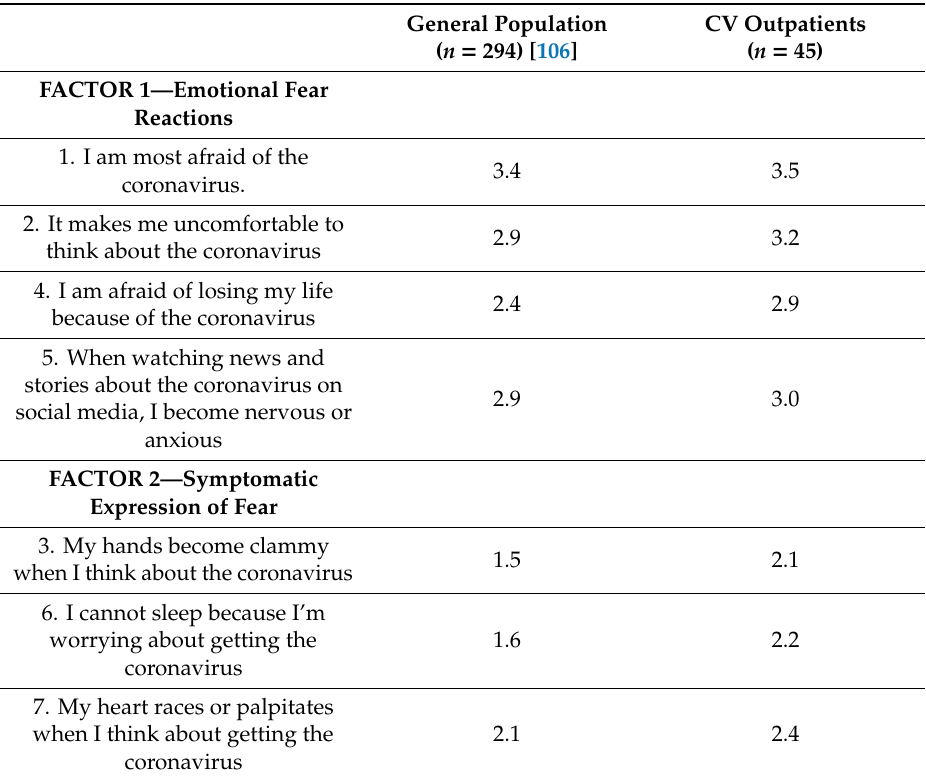
Table 2. Mean of the items of the Italian Fear of COVID-19 test, in a general population and in cardiovascular